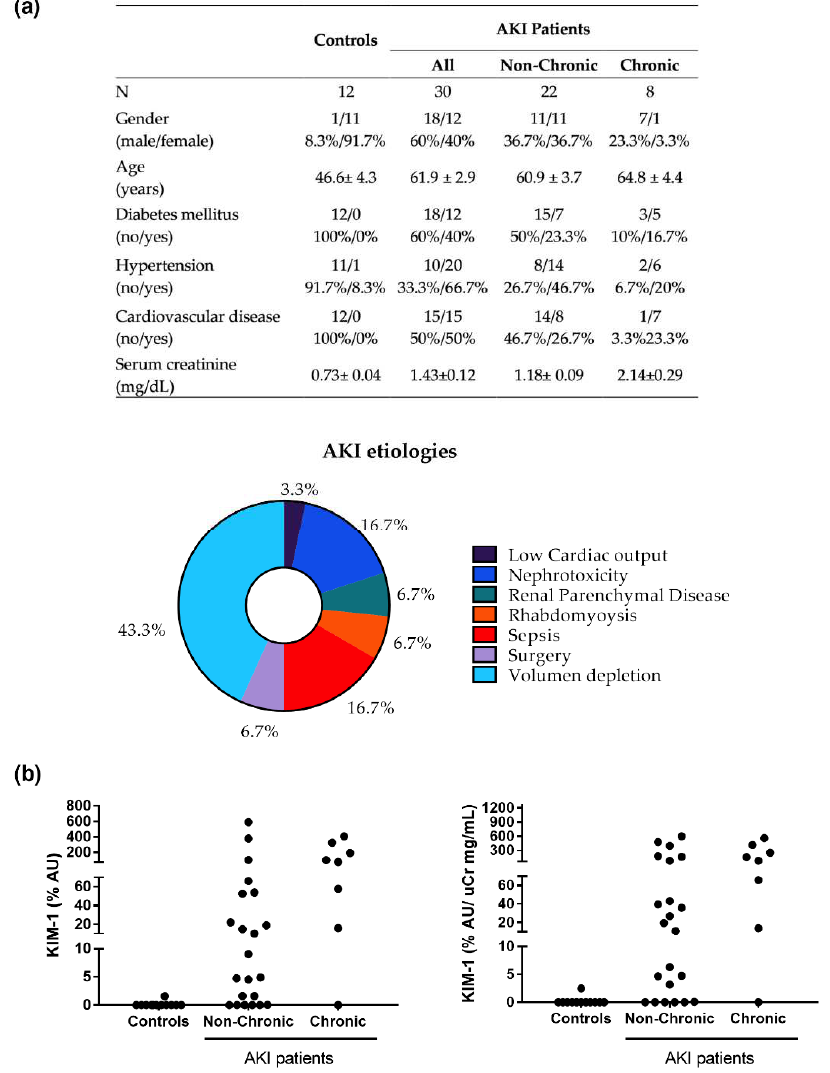
Figure 7. Urinary excretion of KIM-1 in patients who had recovered from an episode of AKI and controls. ( a ) Study population characteristics. ( b ) Urinary KIM-1 level after serum Cr had returned to the values prior to the AKI episode in patients with previous CKD (i.e., chronic) and in patients without previous CKD (i.e., non-chronic), and controls ( left panel ). Urinary KIM-1 levels (as in B) normalized by urinary creatinine concentration (uCr) ( right panel ). AU: arbitrary units.